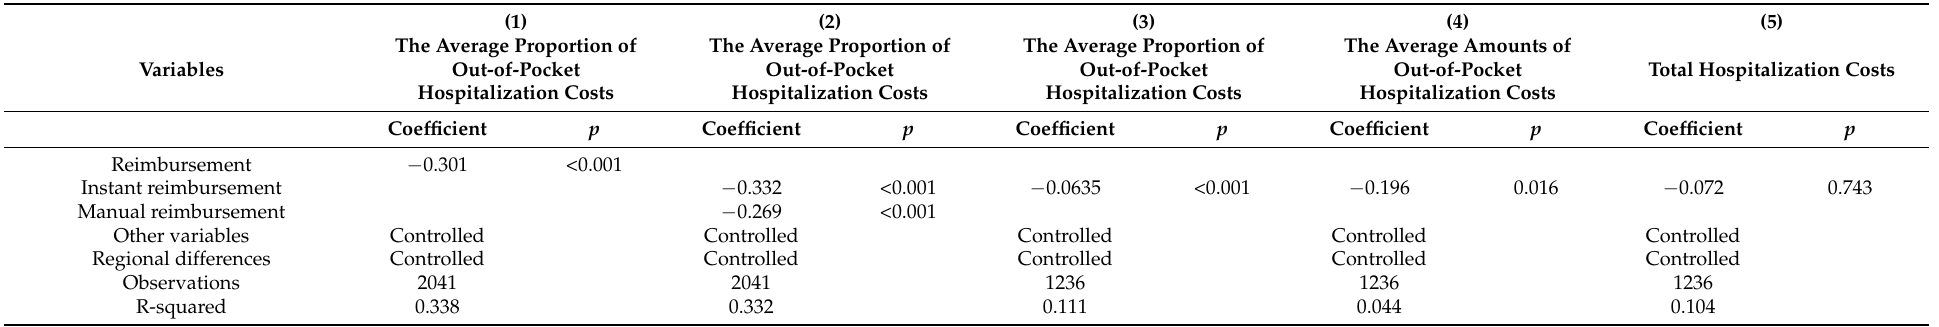
Table 3. The regression results for the impact of instant reimbursement on the hospitalization costs of the floating